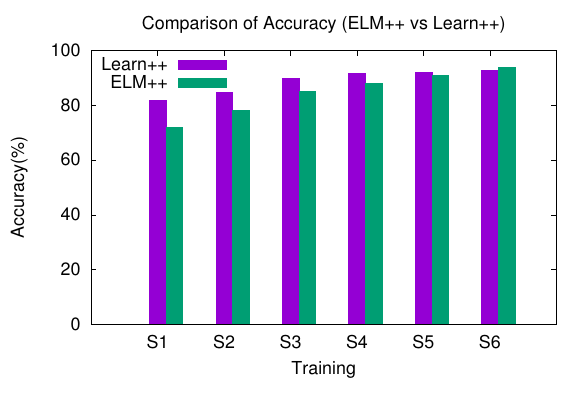
Figure 10. Comparison of accuracy for MNIST Database.